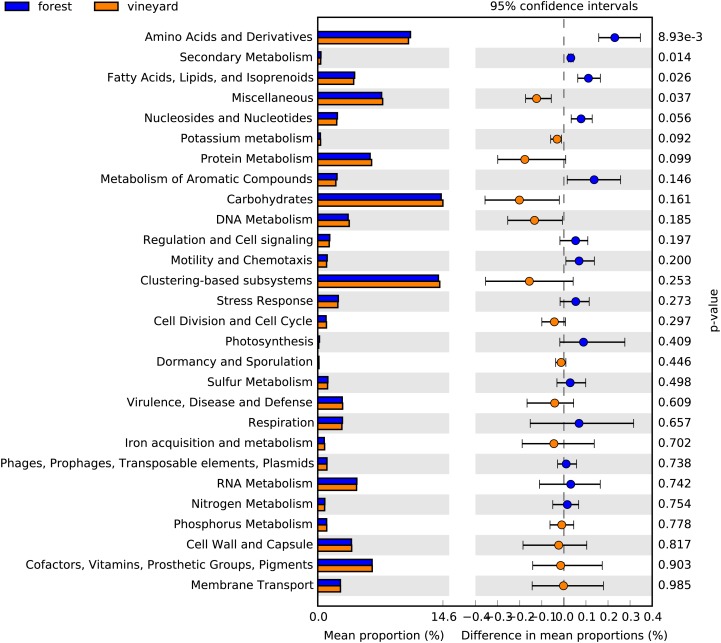
Functional categories found in soil microbial communities.Bar plot showing the mean proportion (%) of functional categories found in soil microbial communities based on the subsystem database. Points indicate the differences between forest and vineyard soils (blue and orange bars, respectively), and the values at the right show the P-values were derived from a White’s non-parametric t-test (White, Nagarajan & Pop, 2009).